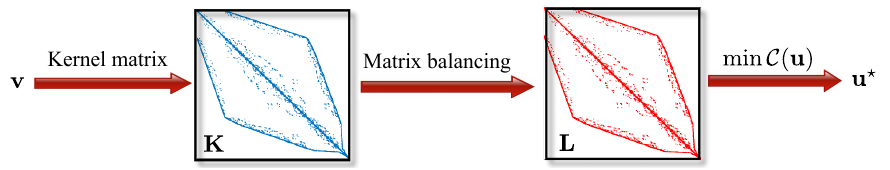
Figure 2. Flowchart of our proposed surface denoising method, where v is the noisy graph signal, and u (cid:63) is the estimated signal.